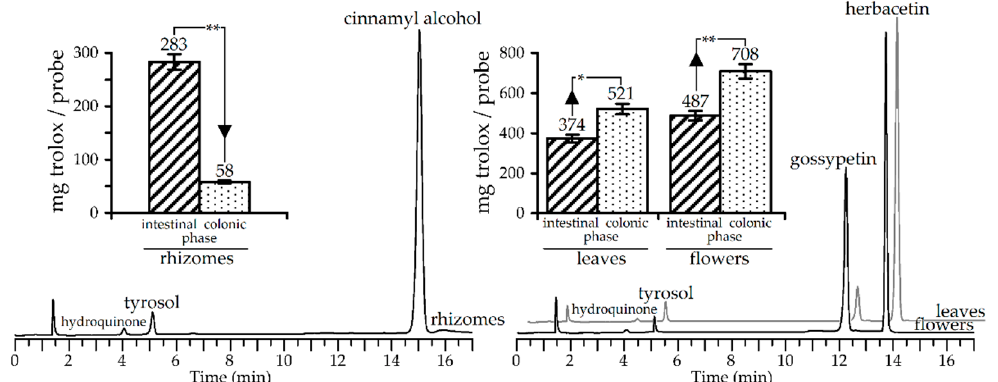
Figure 4. HPLC-DAD profiles of R. rosea extracts (rhizomes, leaves, flowers) after 24 h incubation with gut microbiota (chromatograms; detector λ 210 nm) and trolox-equivalent content in the incubation media (bars; intestinal and colonic phase data showed as comparision). * p < 0.05 vs. colonic phase group; ** p < 0.001 vs. colonic phase group.